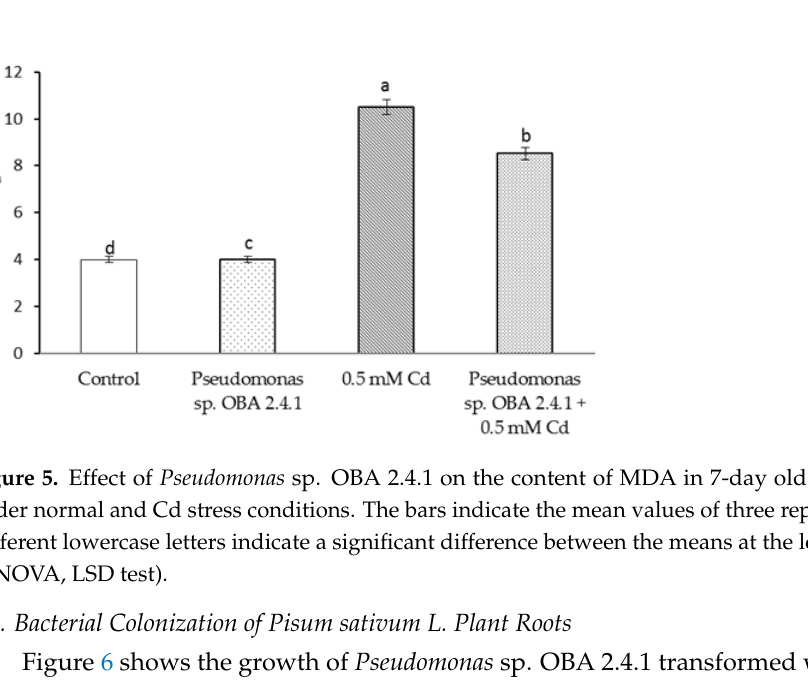
6 of 11 Table 1. Average length of seedlings of pea plants under different concentrations of cadmium. The presented data are the average of three repetitions (n = 50). Concentrations of Cd, mM